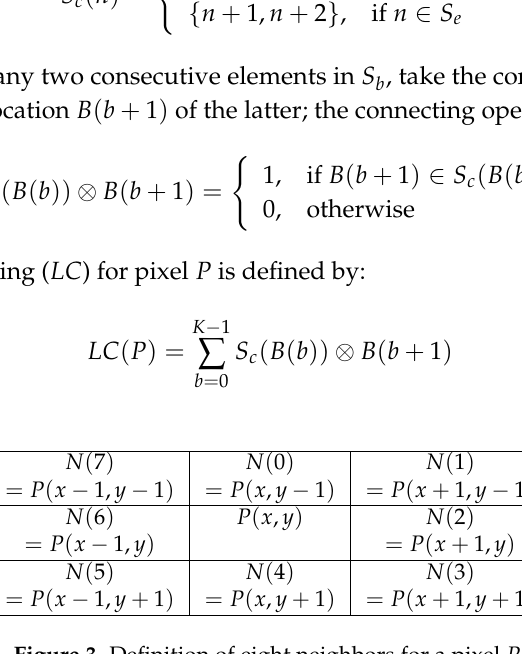
Figure 3. Definition of eight neighbors for a pixel P